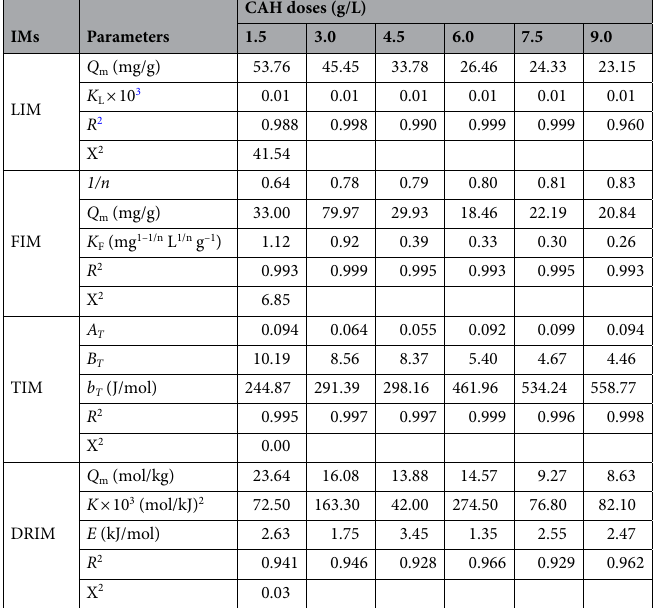
DRIM constants and R 2 measured are shown in Table 2. The Q m estimated for absorption of DB86 dye is 23.64 mg/g, which is lower than Q m calculated from the LIM. The calculated E values are 1.35–3.45 kJ/mol, which is below 8 kJ/mol proposing that the physico-sorption process plays an important role in the absorption of DB86 dye by CAH. On the basis of the error analysis function (chi-square error, X 2 ) to measure the goodness-of-fits IM, it can assume that the TIM is the best IM for the adsorptive removal of DB86 dye by CAH (Fig. 11e). Absorption kinetic studies. The kinetic models (KMs) results of DB86 dye absorption by CAH were studied to realize the mechanism of absorption. Five KMs were employed including, Elovich (EM), pseudo-first-order (PFOM), pseudo-second-order (PSOM), liquid film diffusion (LFD), and intraparticle diffusion (IPDM) mod- els. The identified parameters for the DB86 dye adsorptive removal by CAH were shown in Tables 3 and 4. The R 2 (values close or equal to 1) represented the degree of agreement between experimental data and model-predicted values. PFOM is expressed by Eq. (9):